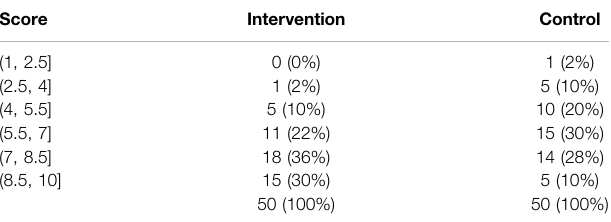
TABLE 2 | Score distribution of patient awareness on warfarin therapy. TABLE 3 | Patients ’ distribution in the percentage of the correct-warfarin-